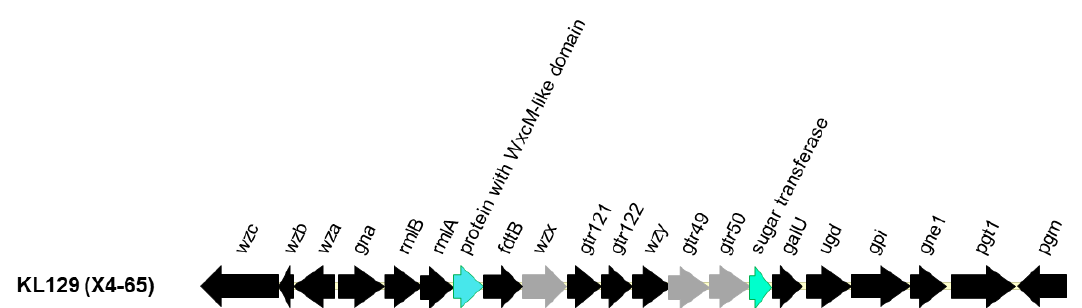
Figure 3. Capsular polysaccharide synthesis ( cps ) gene clusters in KL129. Capsular polysaccharide synthesis ( cps ) locus of KL129, which was identified in this study, was compared with that of BAL_329, an A. baumannii strain with KL60 capsular type (Accession No. MN148382.1). Open reading frames are shown as arrows. Comparing the two cps loci, conserved genes that shared > 95% amino acid identity with KL60 are shown in black. Genes that share 80–95% amino acid identity with KL60 are shown in grey, and genes sharing < 80% amino acid identity with KL60 are shown in green or blue for the corresponding genes.